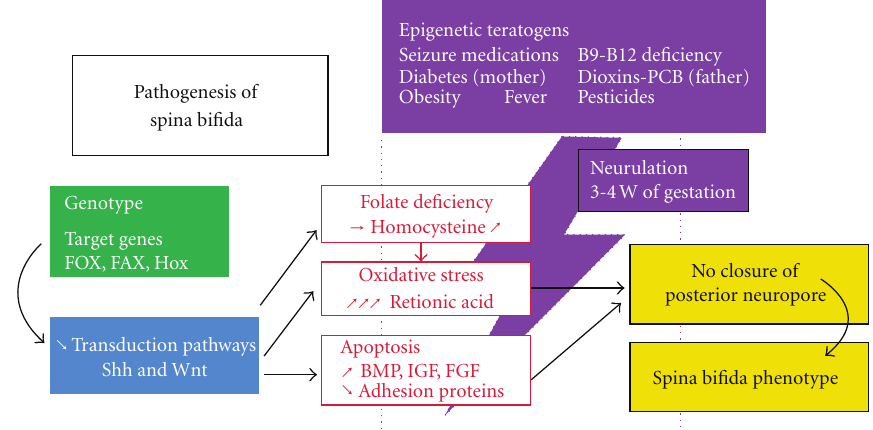
Figure 2: Combined etiopathogenesis of spina bifida (Shh: sonic hedgehog, Wnt: Wnt ligand in Wnt/ β catenin signaling pathway, BMP: bone morphogenic protein, IGF: insulin-like growth hormone, and W: weeks) [18].